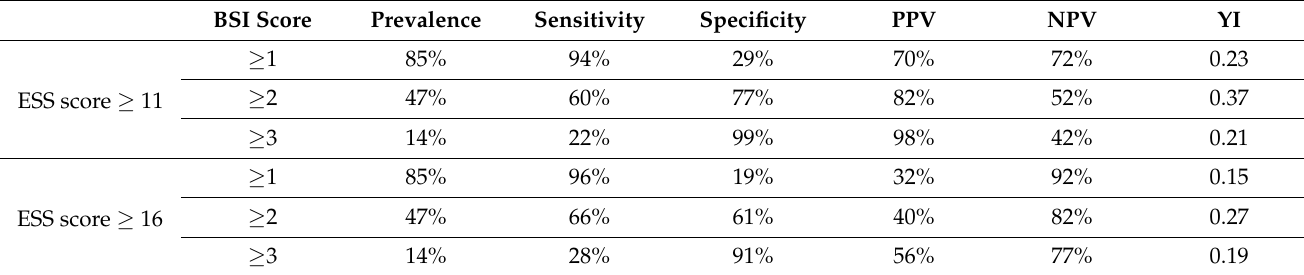
Table 3. Ability of BSI score to predict EDS, according to ESS score.